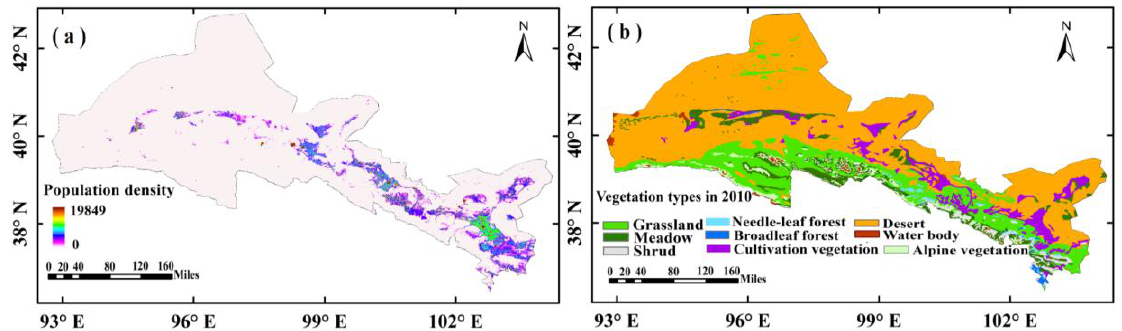
Figure 2. Maps of population density ( a ) and vegetation types ( b ) of the Hexi Corridor in 2010.